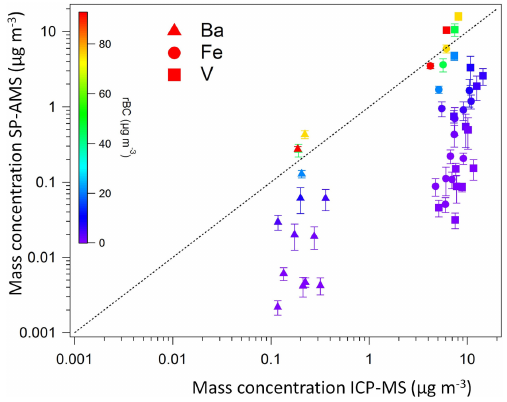
Figure 8. The metals barium, vanadium and iron measured with the SP-AMS vs. those collected with the NanoMOUDI and analyzed with the ICP-MS method (in µgm − 3 ) at the heating Figure 7. Sulfate fragmentation patterns, SO + vs. SO + (a) , SO + 2 3 vs. SO + (b) , HSO + vs. SO + (c) and H 2 SO 4 + (d) during the field 3 experiment at the heating station. For comparison, the black crosses represent the measurements solely with the tungsten vaporizer.